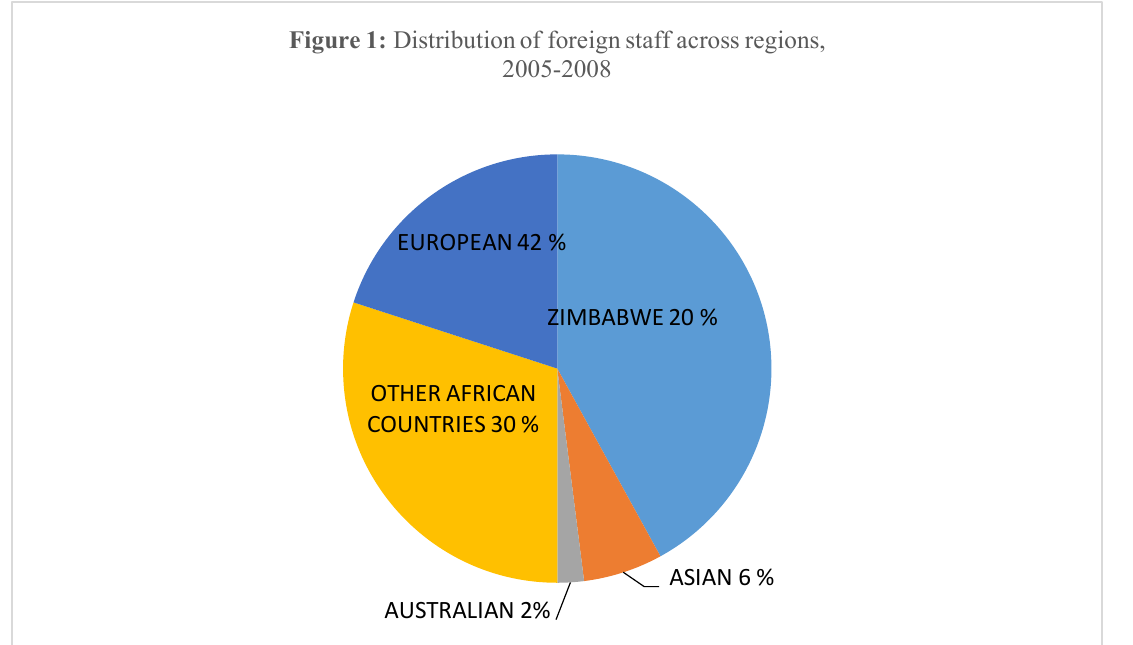
Figure 1: Distribution of foreign staff across